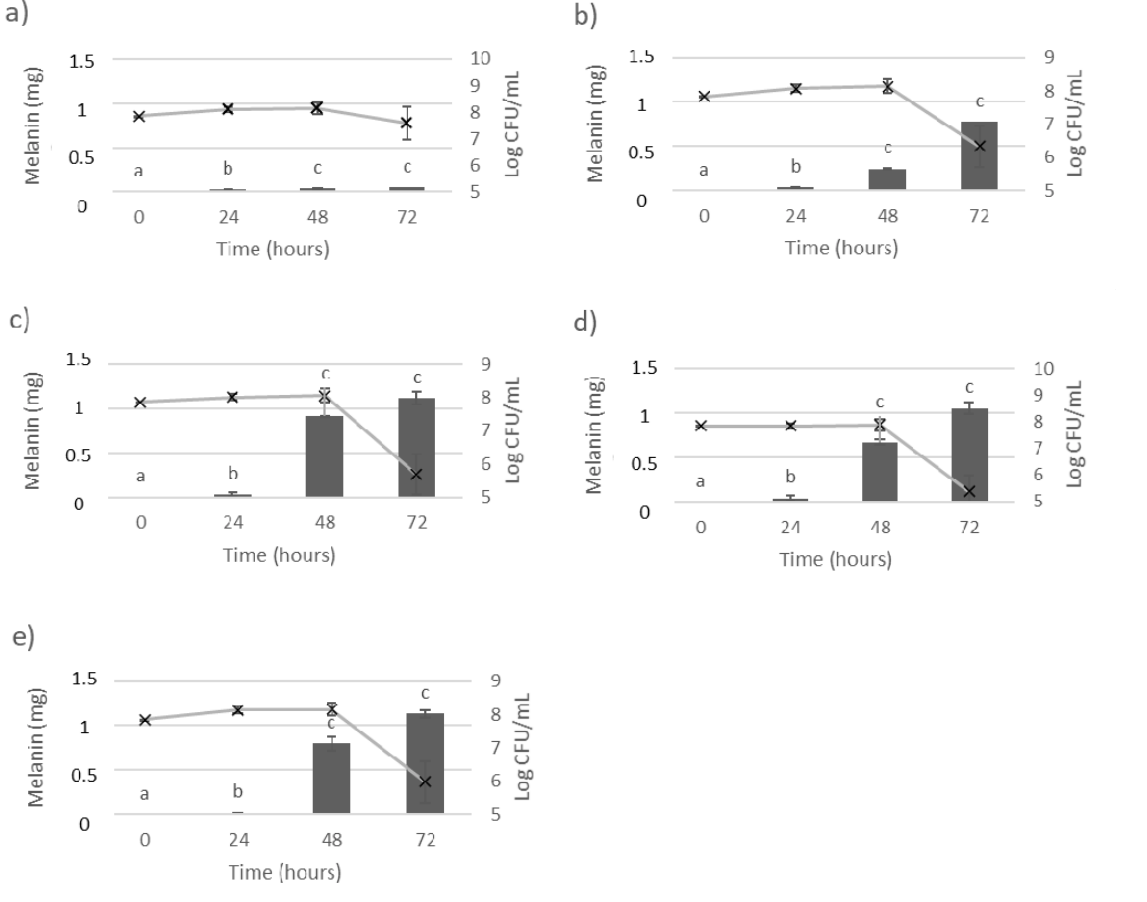
Figure 1. Influence of L-tyrosine concentration in Pseudomonas putida ESACB 191 growth and melanin bioproduction. The lines represent the P. putida ESACB 191 growth (Log CFU/mL) and bars represent the melanin bioproduction (mg), according to different amounts of L-tyrosine in the medium: ( a ) 0 mg/mL; ( b ) 1 mg/mL; ( c ) 2.5 mg/mL; ( d ) 5 mg/mL; ( e ) 10 mg/mL. The error bars values were calculated based on three replicates for each condition; different superscript letters ( a – c ) correspond to values in the same extraction condition that can be considered statistically different at confidence level of 95%.